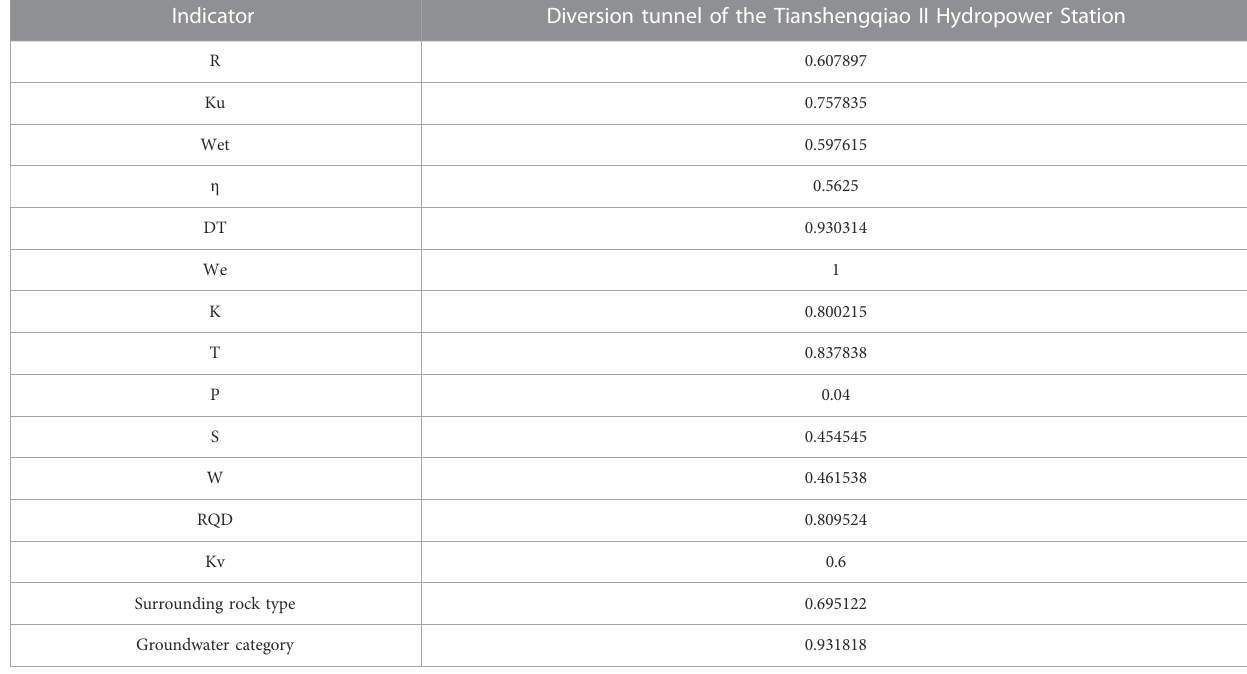
TABLE 6 Data after dimensionless processing. Indicator